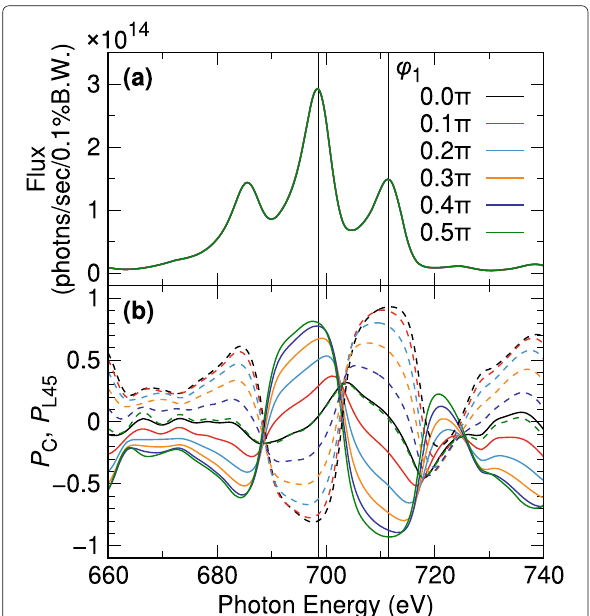
Fig. 8 Spectra of “ID07.” Calculated a energy spectra and b degree of polarization for “ID07” at (cid:2) ω 1 =700 eV in CP mode using eight IDs. ϕ 1 is the phase at the odd-number PSs. The sum of the phases ϕ 1 and ϕ 2 at the odd- and even-number PSs is 2 π . Solid and dashed lines are P C and P